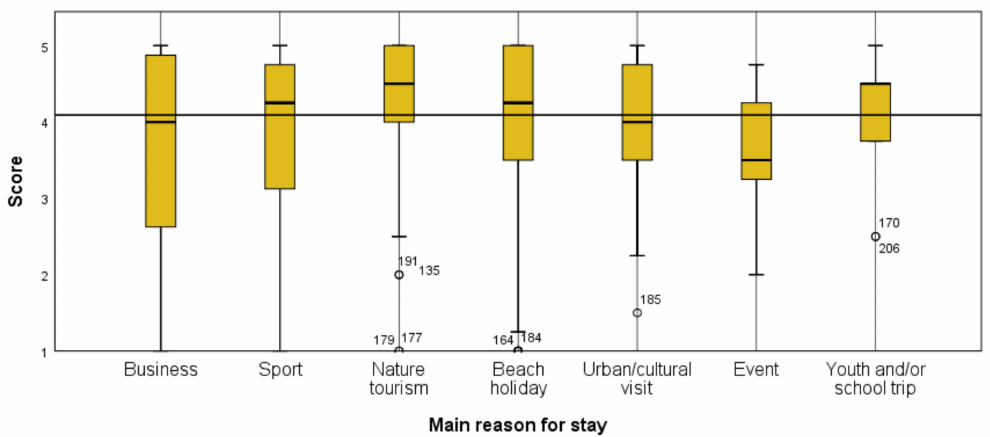
Figure 3. Frequency with which guests engage in water-saving practices by main reason for stay on a scale of 1 (never) to 5 (always).